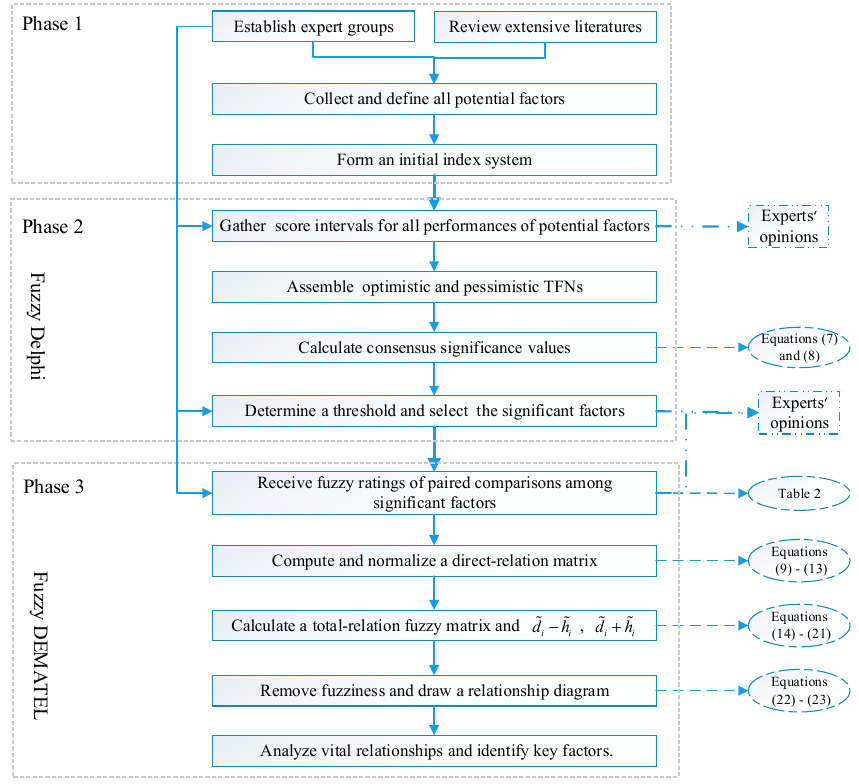
Figure 2. A fuzzy Delphi-DEMATEL based framework of energy efficiency financing barriers analysis.